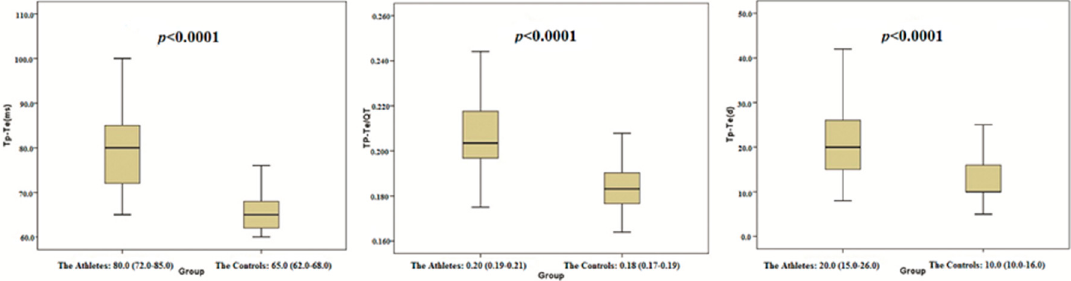
Figure 2. Comparison of Tp-Te, Tp-Te/QT and Tp-Te (d) between the athletes and the controls.